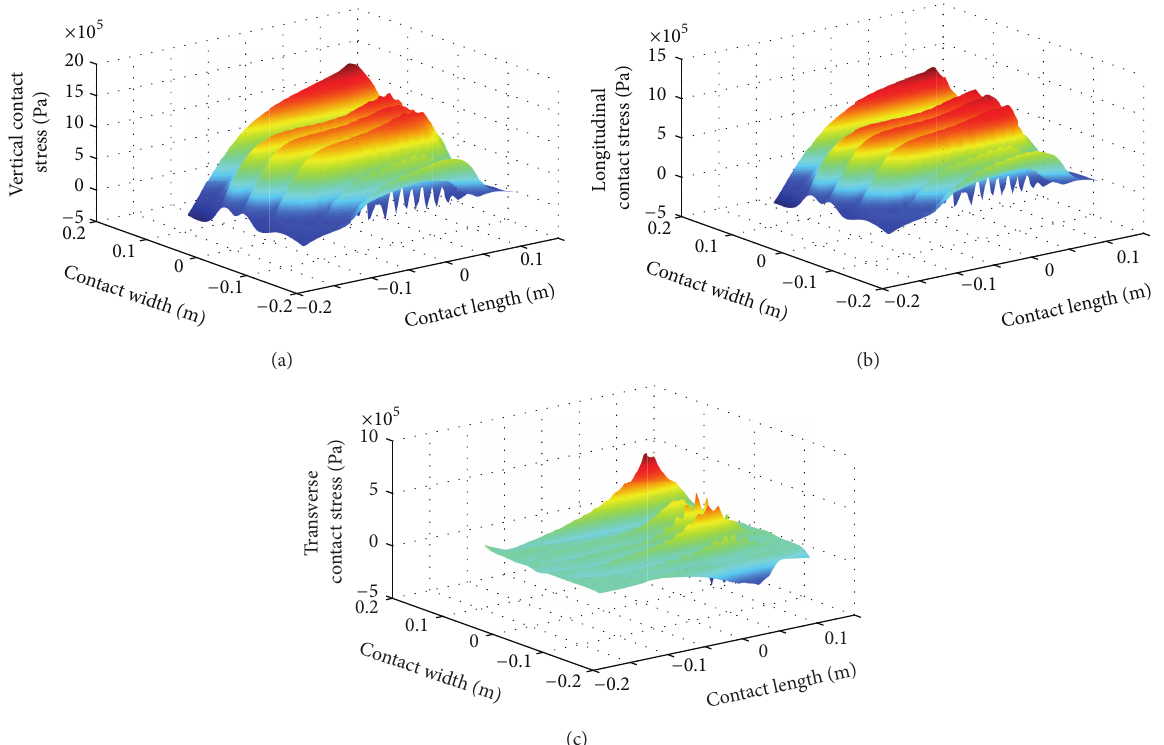
Figure 15: Contact stress distribution under braking condition with